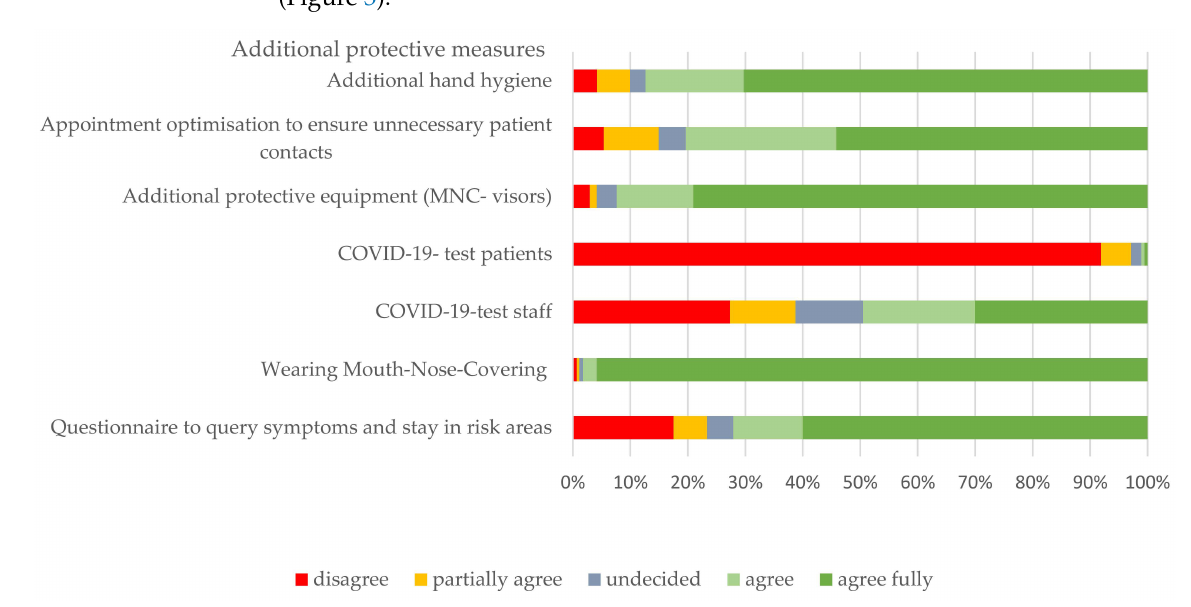
Figure 3. Participants’ assessment of the usefulness of the additional protective measures